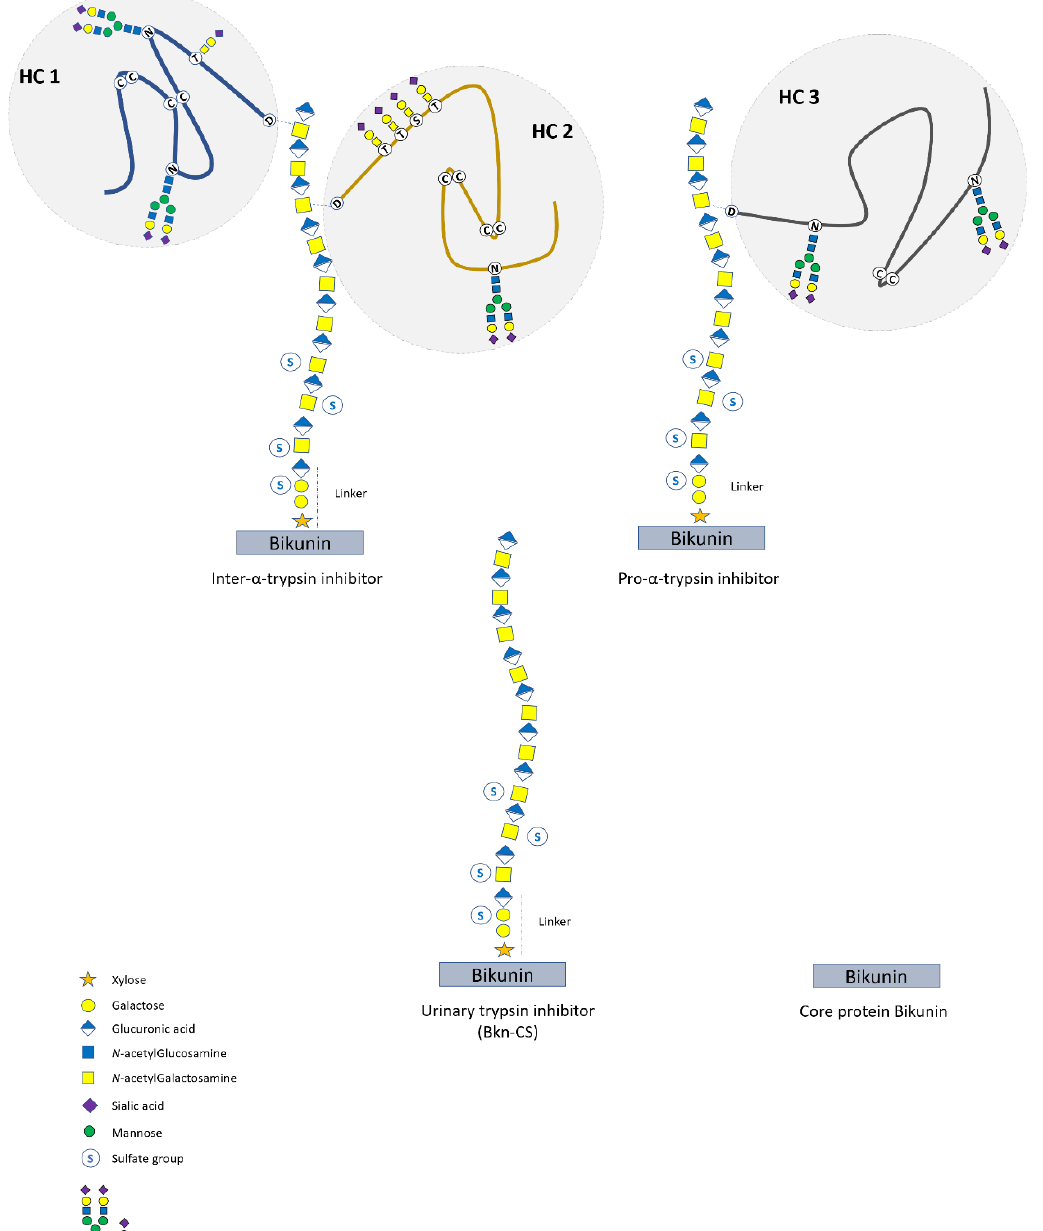
Figure 4. Schematic structure of bikunin isoforms (IAIP). The heavy forms ITI and P α I result from the esterification of the glycoproteins HC1, HC2, and HC3 with the CS chain of the bikunin (Bkn) core protein. The light forms correspond to UTI (Bkn – CS) and the core protein Bkn. The CS chain consists of 15 +/ − 3 [GlcA – GalNAc] disaccharide units and is sulfated at several GalNAc residues and at the second Gal residue of the linker region.